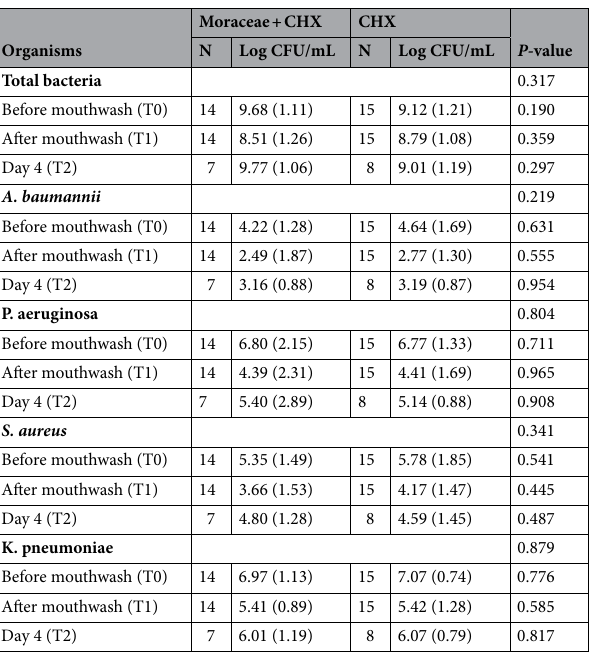
Table 2. Microbial count comparison of mouthwash groups at the baseline, immediately after, and on day 4. Data are presented as the mean (standard deviation). a Missing value in T0 because of inadequate sampling for the microbial study. b P-value; over time in each subgroup using generalized estimating equation and in pairwise time using Student